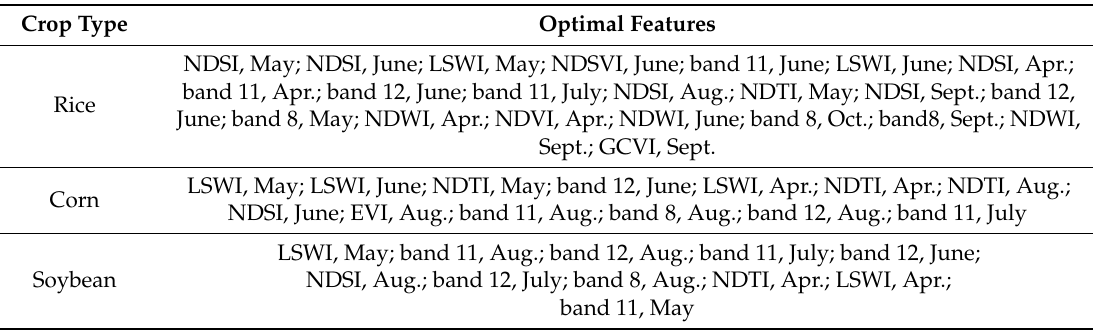
Table 3. Individual optimal features for rice, corn, and soybean selected by the ASTFS method. Crop Type